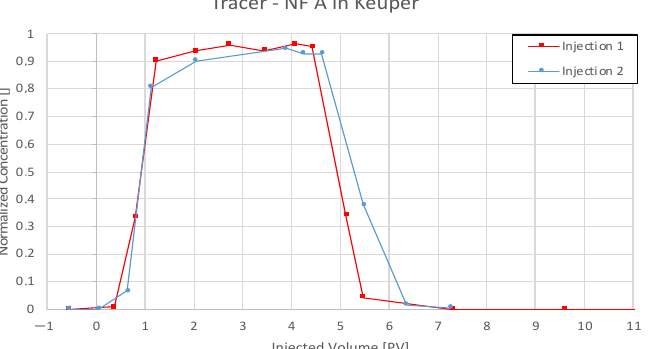
Figure 11. In the first injection step, the nanofluid shows a delayed breakthrough forming a peak at 0.11 wt%. The effluent concentration decreases faster compared to the tracer. In the second injection step, nanomaterials are now delayed to the tracer but also exceed the injected concentration. This behaviour creates a calculated NF recovery of ~77% and ~112%, respectively. FFF and DLS data confirm these concentration measurements by showing an NF concentration of 106% compared to blank samples. Particle size analysis suggests that larger particles arrive earlier in both injection steps. The comparison seen in Figure 12 shows a very similar trend for tracer concentration history in both injection